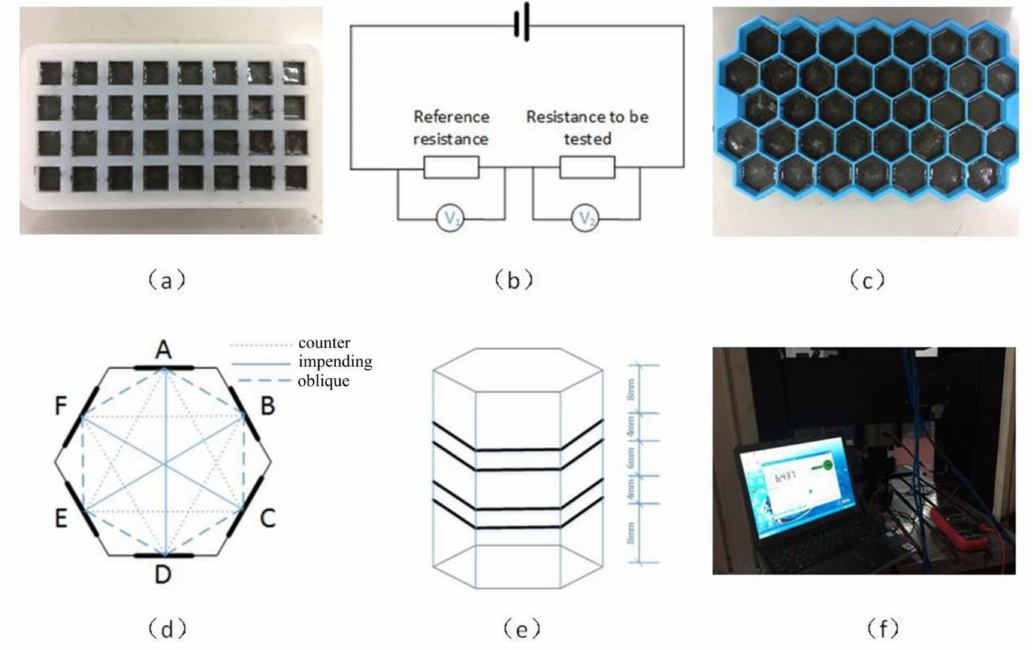
Figure 1. Preparation and Pressure-Sensitivity Test of CNFUC specimen. ( a ) Static resistivity test block of CNFPUC; ( b ) Two-electrode reference resistance method for static resistivity of CNFPUC specimen; ( c ) Preparation of CNFPUC hexahedron specimen; ( d ) Resistance test of CNFPUC hexahedron specimen; ( e ) The four-electrode position diagram for measuring the sensitivity of CNFPUC hexahedron; ( f ) Measurement of sensitivity of CNFPUC mixture by four-electrode